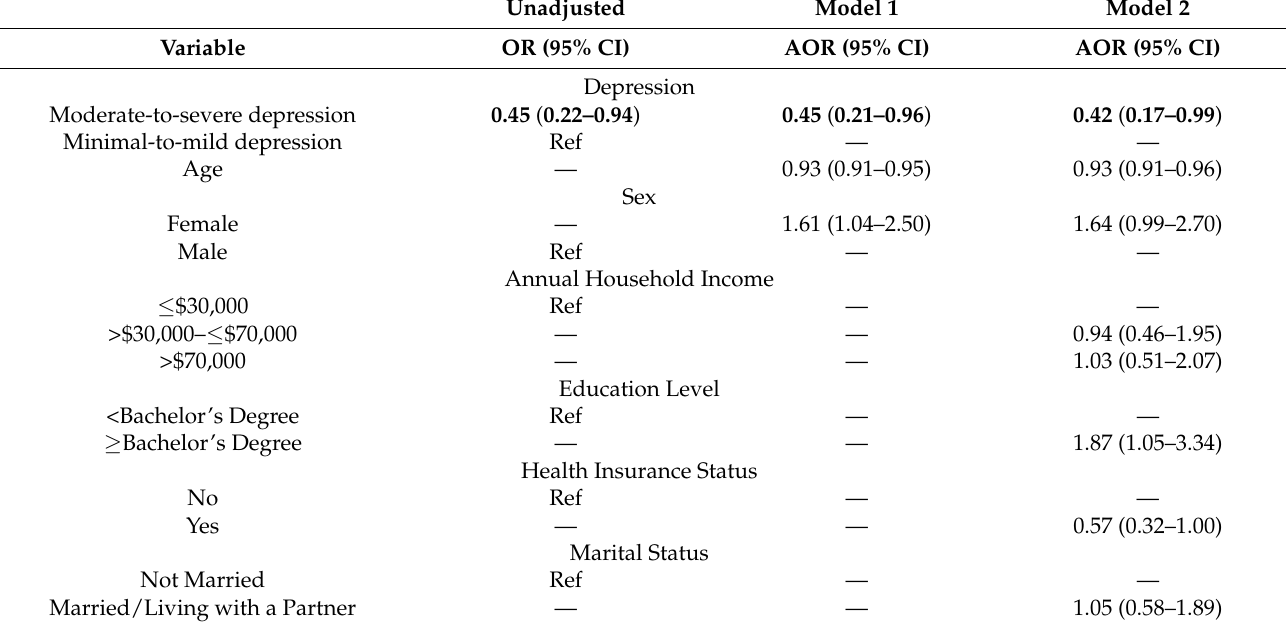
Model 1: xxxxxx. Model 2: Adjusted for age, sex, annual household income, education level, health insurance status, and marital status. Bold , statistically significant at p ≤ 0.05. OR: Odds Ratio; AOR: Adjusted Odds Ratio; 95% CI: 95% Confidence